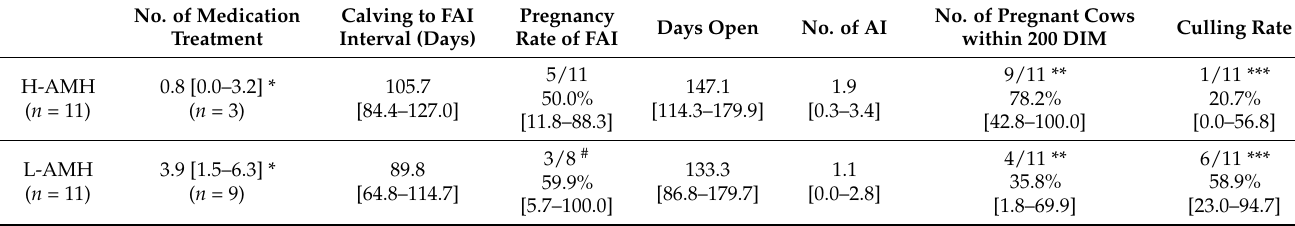
FAI: first artificial insemination; DIM: days in milk. A linear mixed model or generalized linear mixed model (link function: logit) with the farm as the random factor and lactation number as the covariate. Data are expressed as the mean and 95%CI. * p = 0.072, ** p = 0.039, *** p = 0.010. # Three cows were culled before conducting the first artificial inseminations. Medication treatment for the following conditions: retained placenta, dystocia, milk fever, ketosis, uterine torsion, udder edema, mastitis, indigestion, and